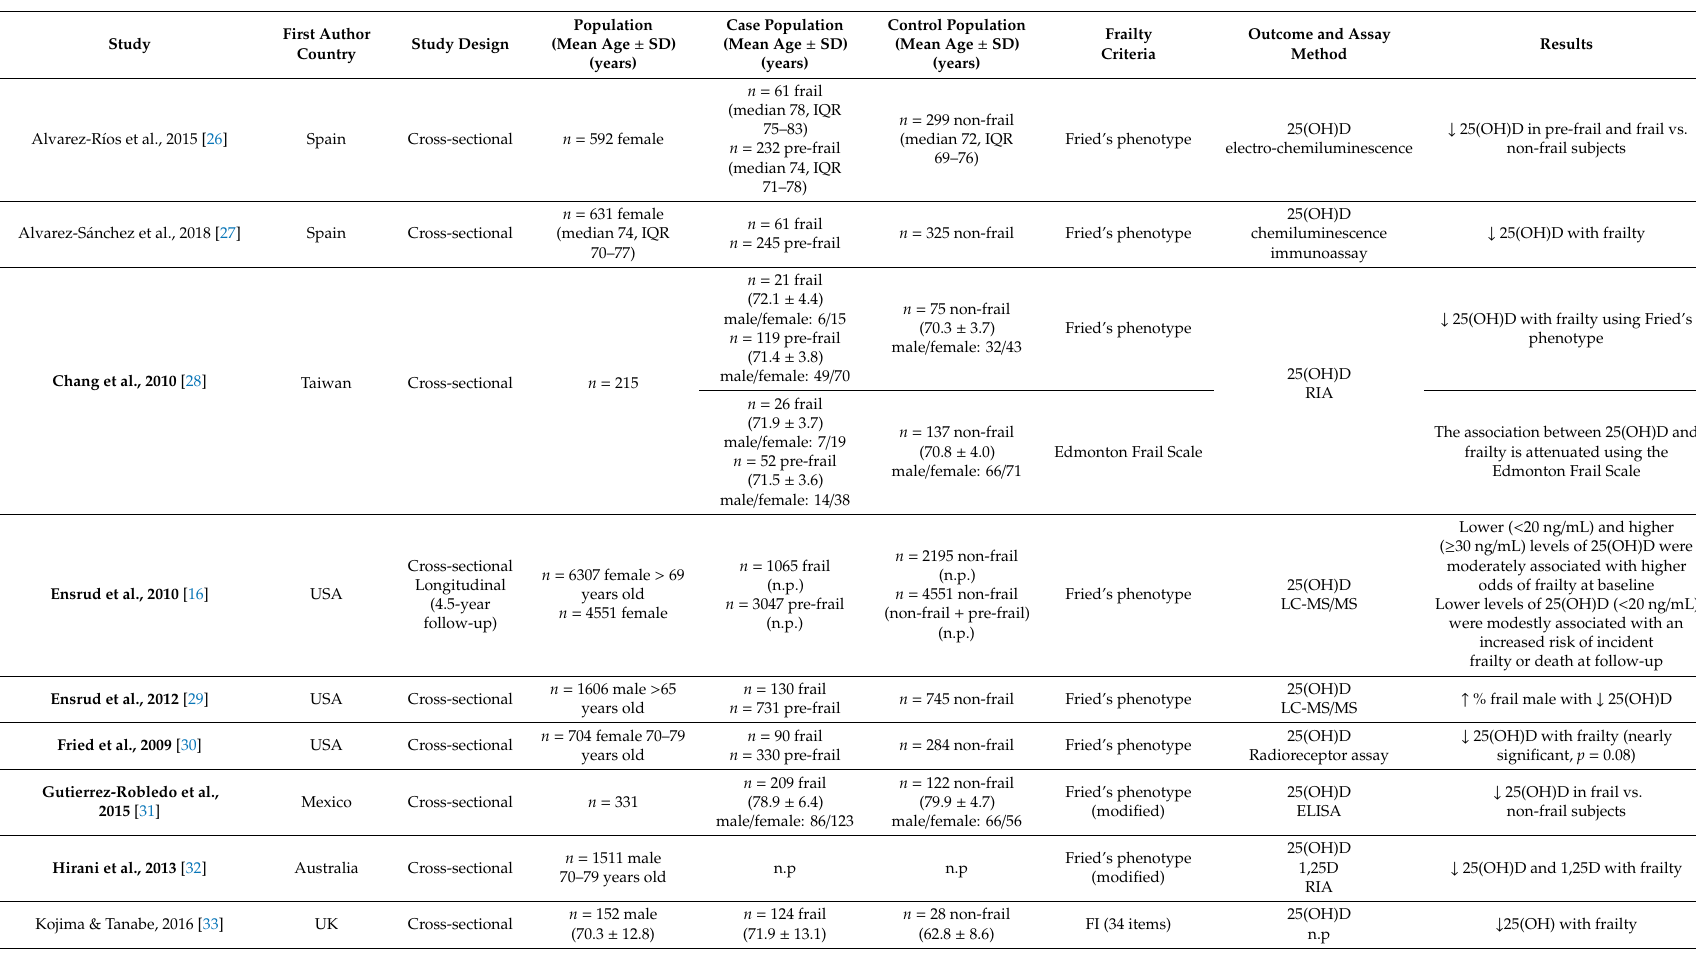
Table 1. Characteristics of the studies included in the systematic review. Studies in bold were included in the